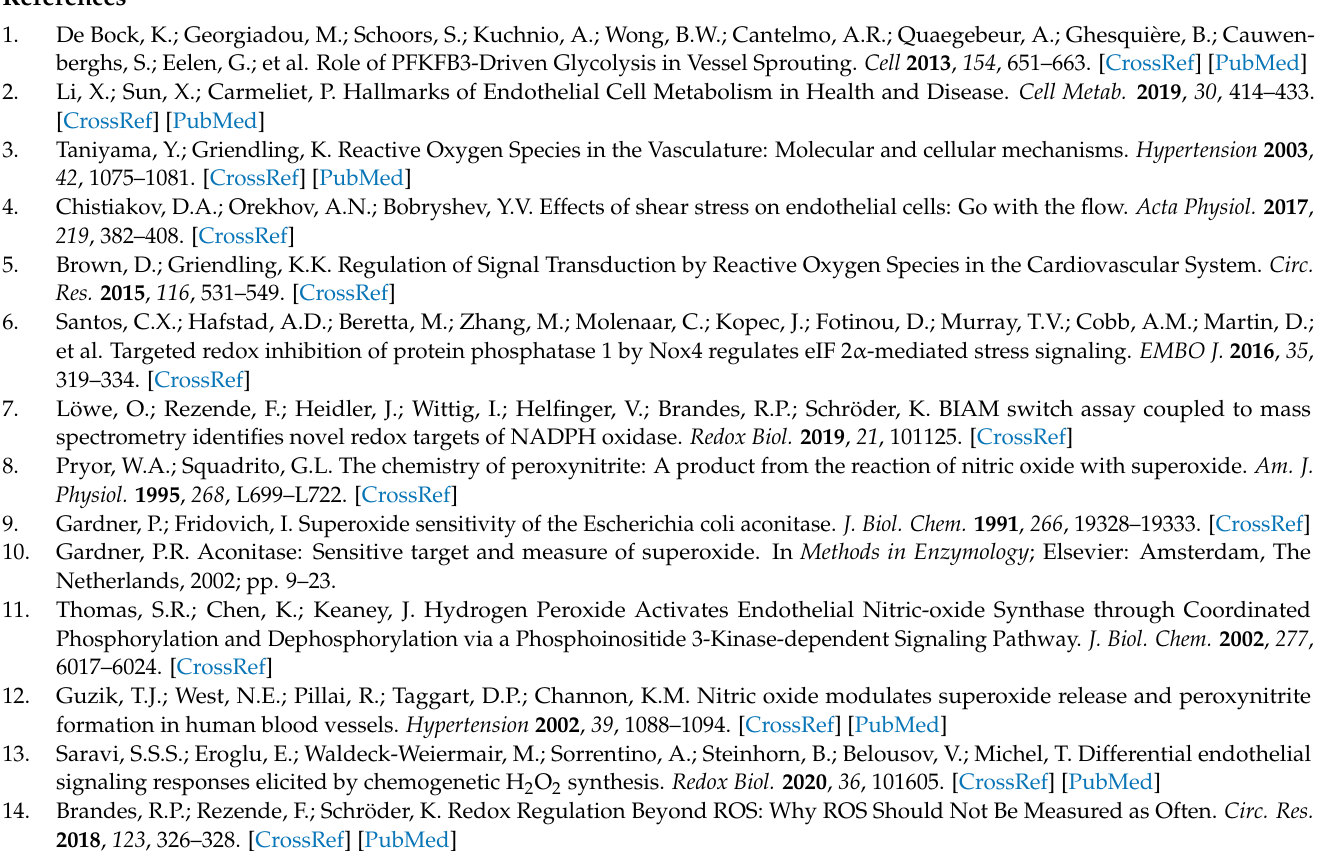
DAO; Figure S2: Changes in glycolysis and nucleotide metabolism in HUVEC in response to different oxidative stimuli; Figure S3: High degree of dissimilarity between effects of different ROS exposures to HUVEC; Figure S4: Differentially expressed genes in HUVEC in response to different ROS; Figure